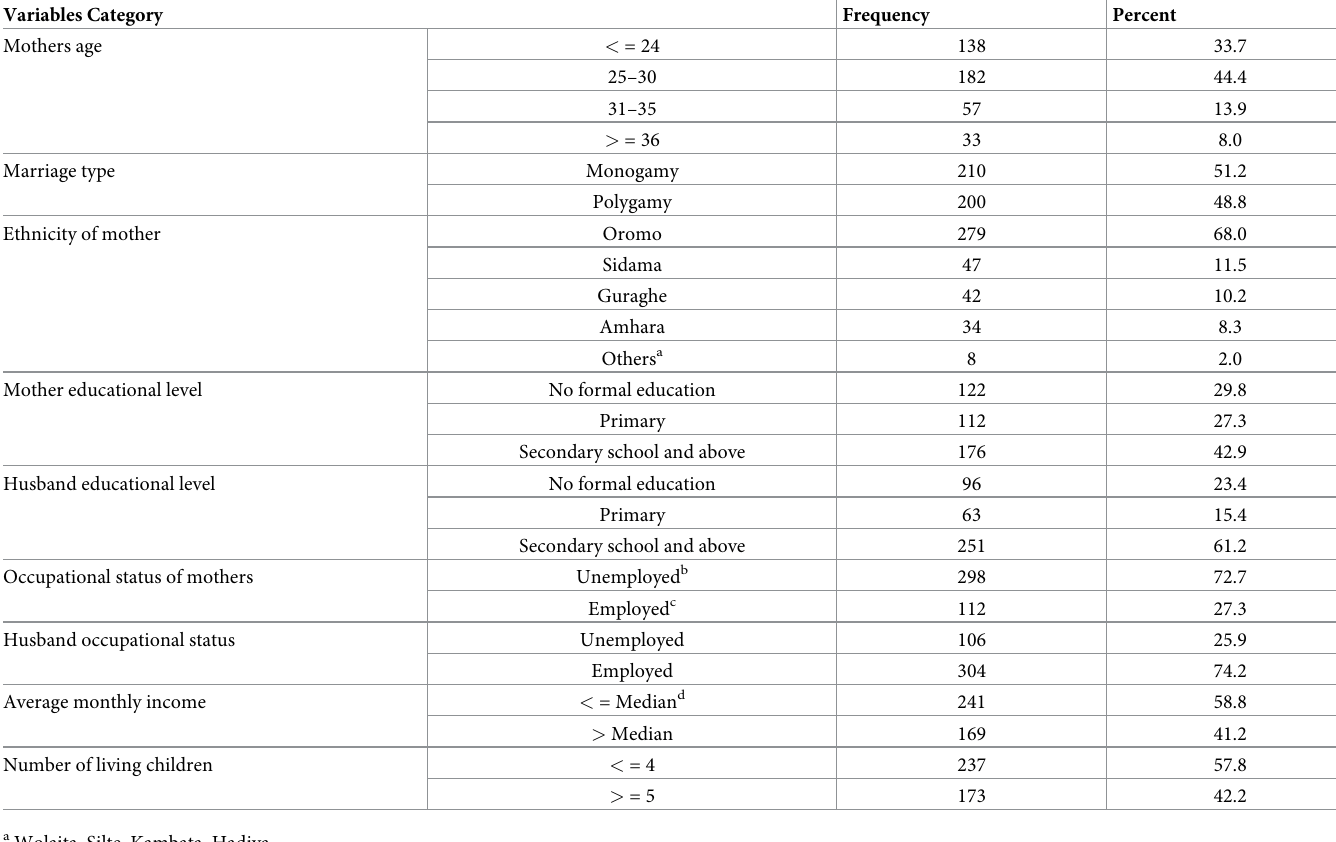
Table 2. Sociodemographic characteristics among postpartum mothers in Shashamane town, Oromia, Ethiopia, 2021. (N = 410). Variables